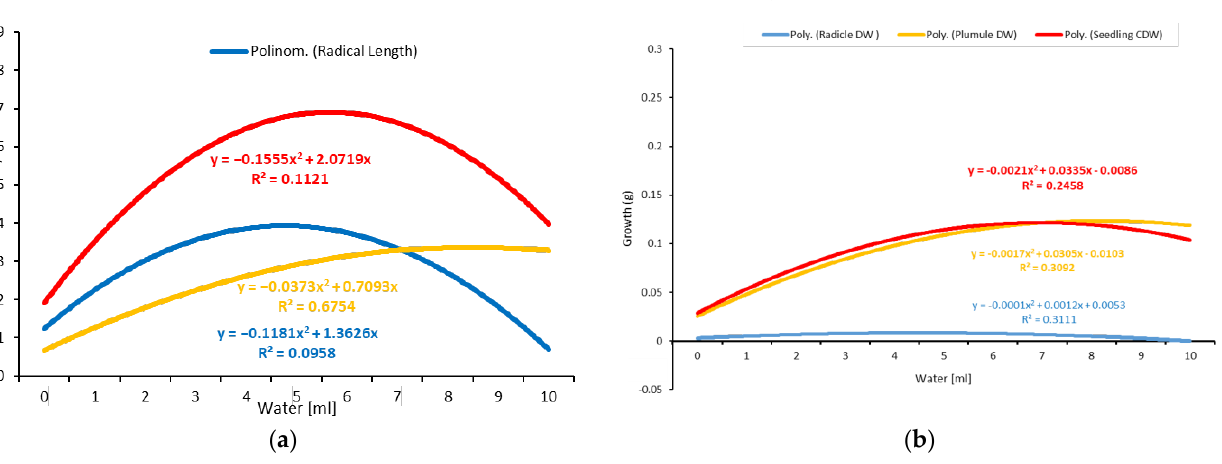
Figure 5. Response of seedlings, plumules, and radicles to different amounts of water tested. ( a ) Growth vs. different amounts of water based on one-milliliter intervals. ( b ) Dry weight accumulation vs. different amounts of water based on one ml intervals.